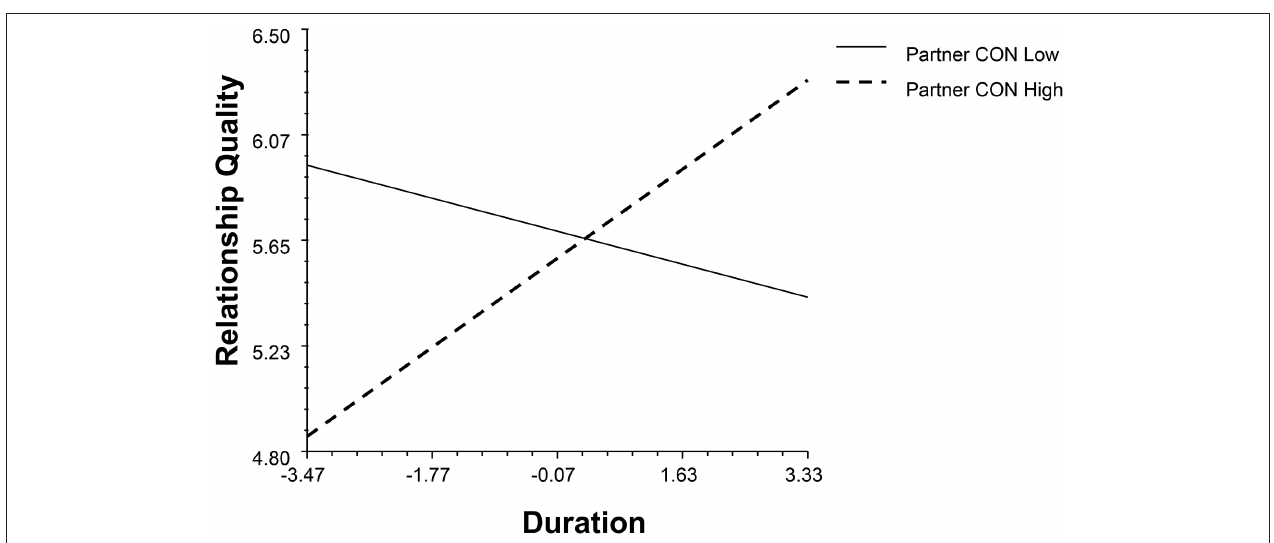
FIGURE 4 | The interaction between partner’s conscientiousness and